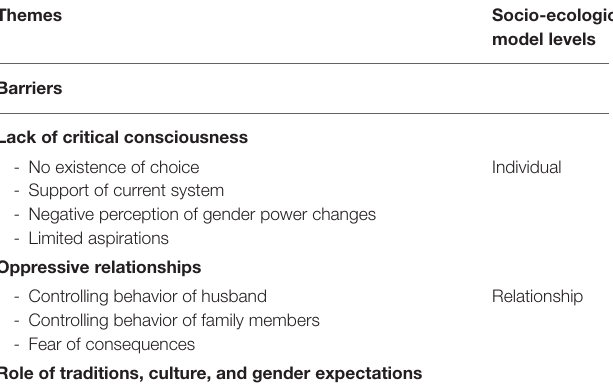
TABLE 2 | Barriers and facilitators themes for women’s empowerment regarding fertility intentions and family planning.